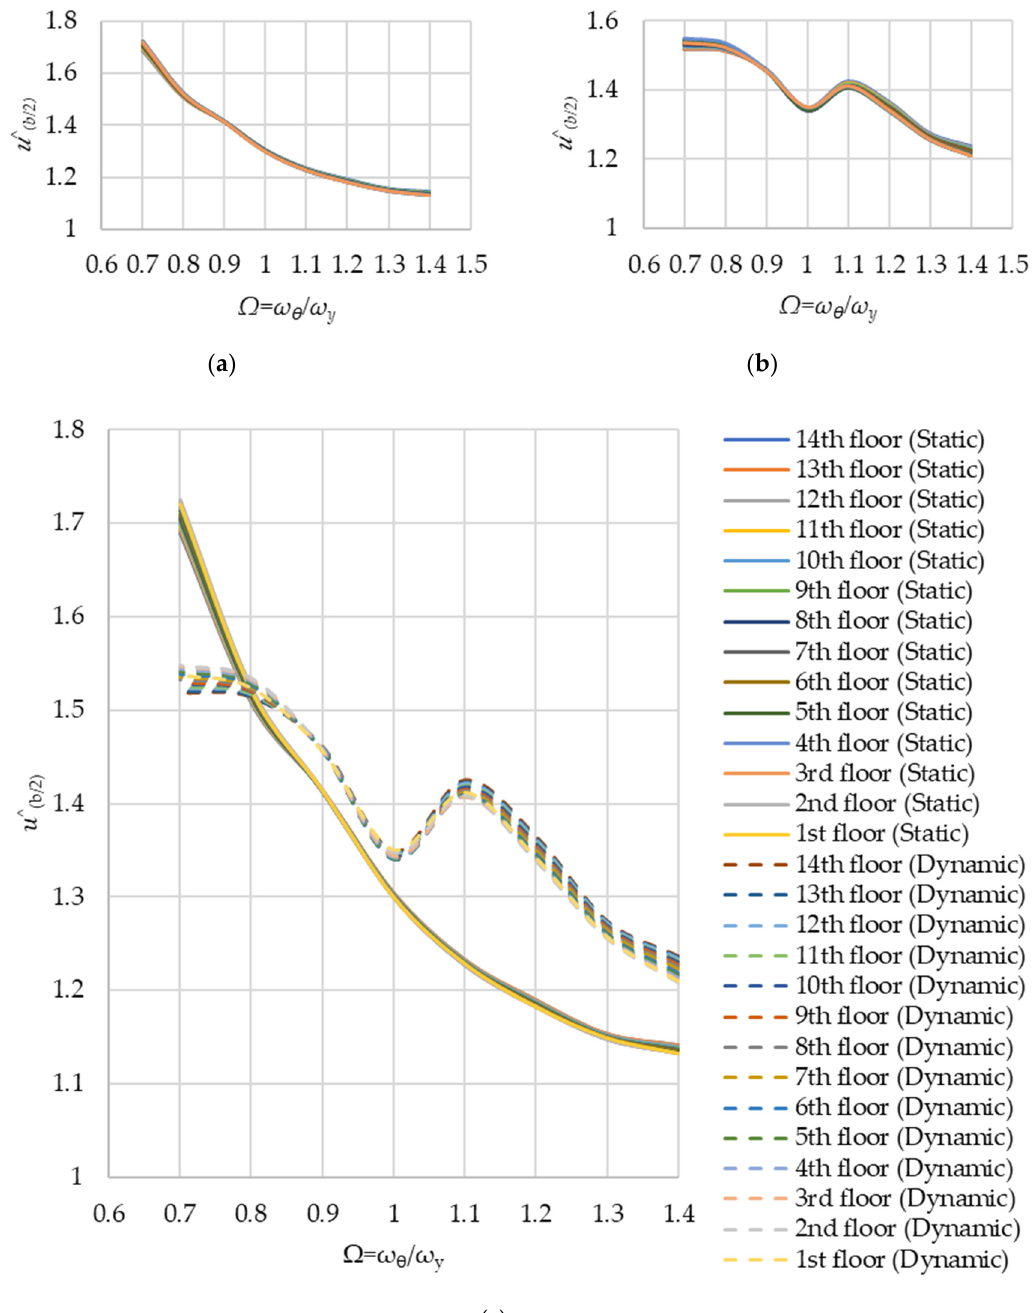
Figure 7. Normalized flexible edge displacement (with b / r = 1.1, Ty > 2 s): ( a ) Static edge displacement; ( b ) Dynamic edge displacement; ( c ) Static vs. dynamic edge displacement.